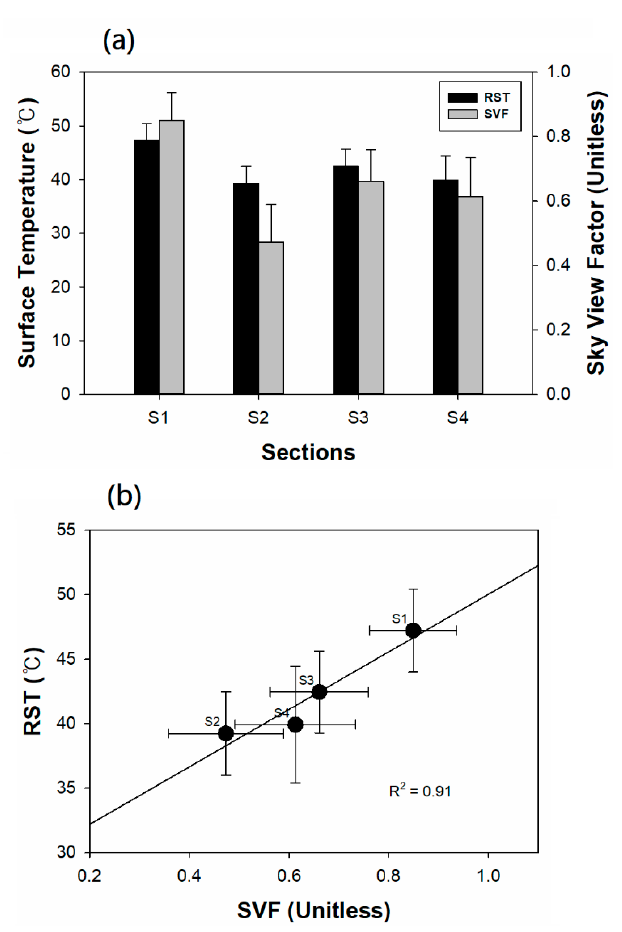
Figure 9. ( a ) The mean and standard deviations of road surface temperature (RST) and sky view factor (SVF) for the different sections, and ( b ) relationship of SVF to RST. The horizontal and vertical error bars denote standard deviations of RST and SVF, respectively.